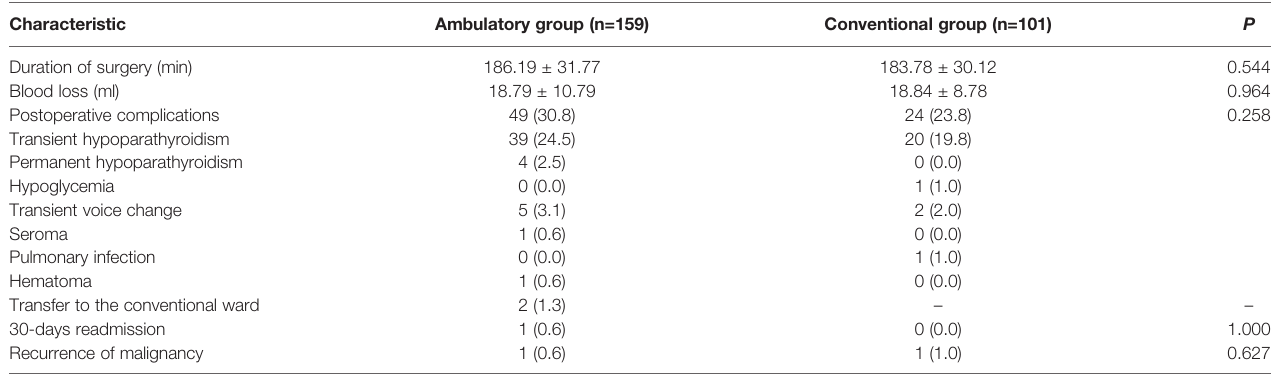
TABLE 2 | Surgical outcomes and prognosis. Characteristic